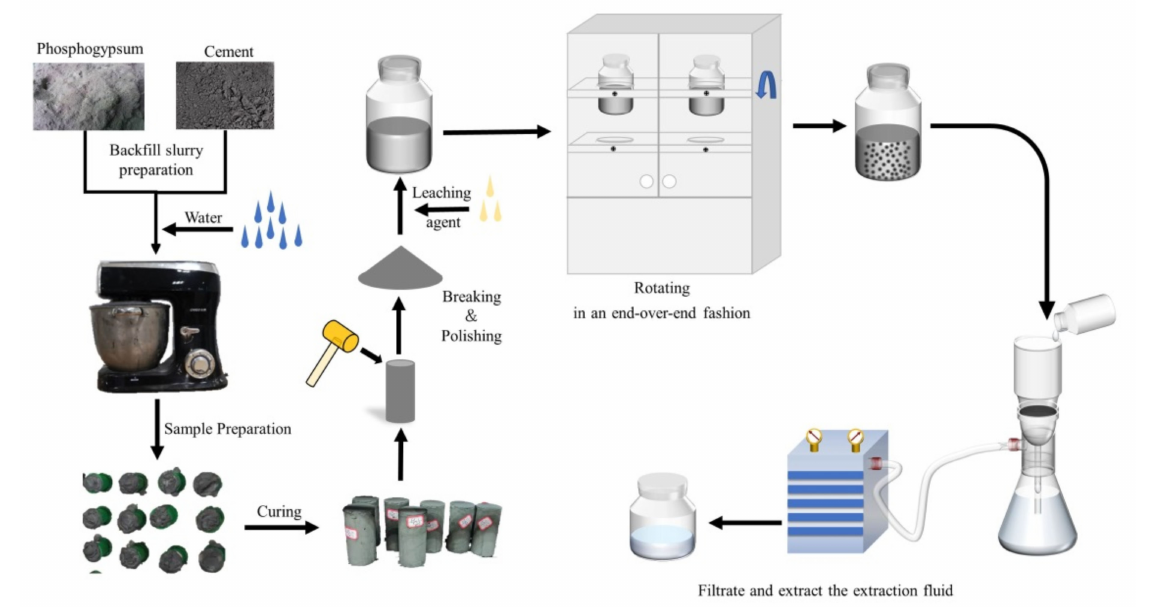
Figure 5. Flowchart of the experimental approach used in this